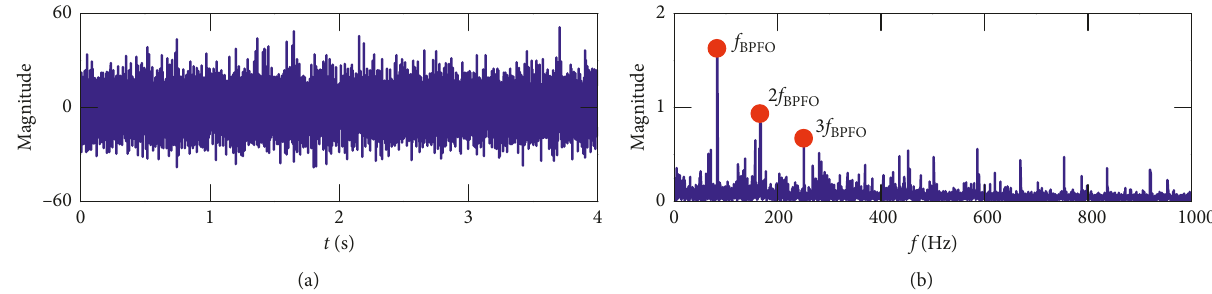
Figure 18: Bearing compound fault signal and squared envelope spectrum: (a) waveform; (b) squared envelope spectrum.